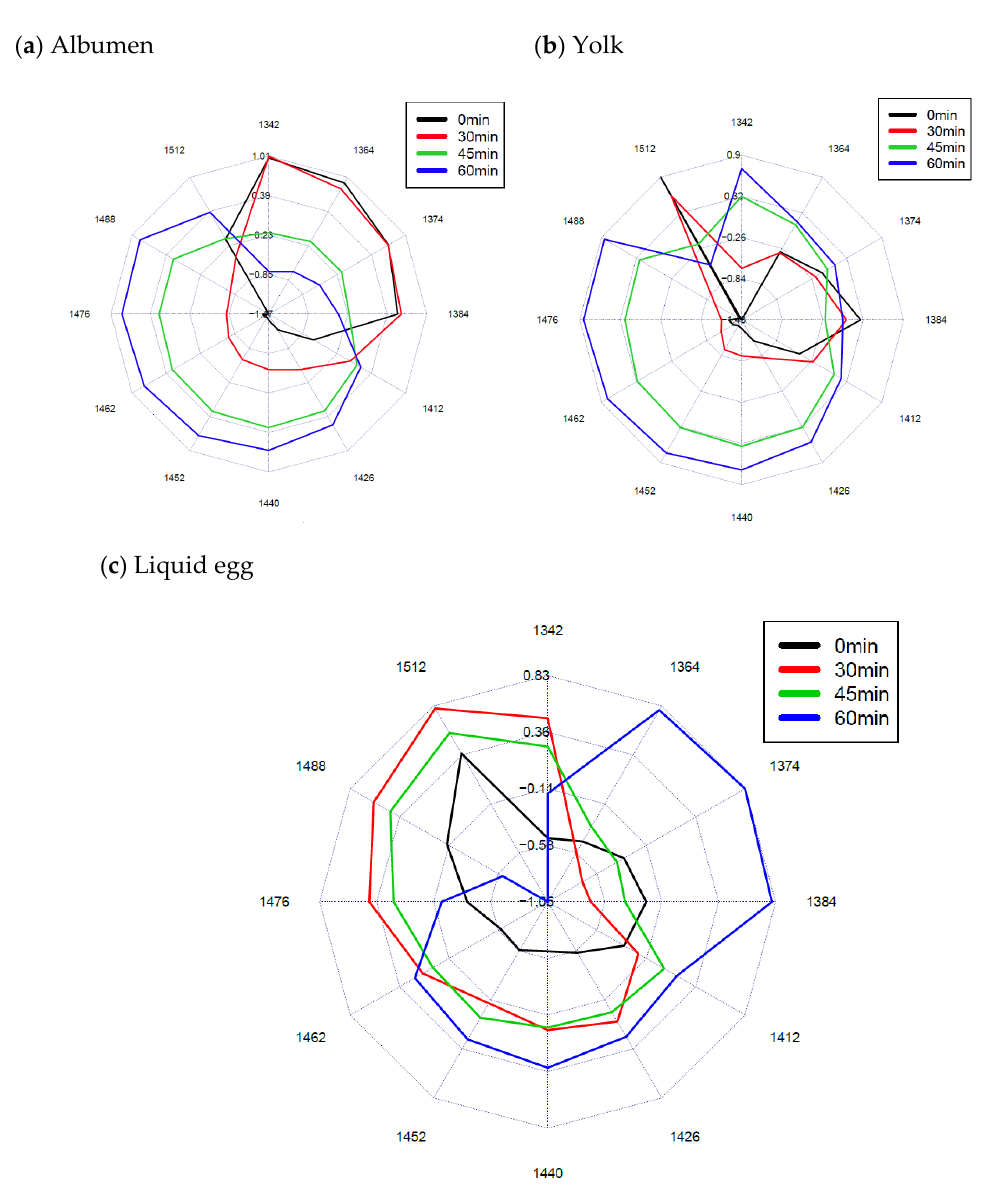
Figure 7. Aquagrams. Average values of normalized absorbance values of the water matrix coordinates of albumen ( a ), yolk ( b ) and liquid egg ( c ) treated at 40 kHz at 6.9 W.